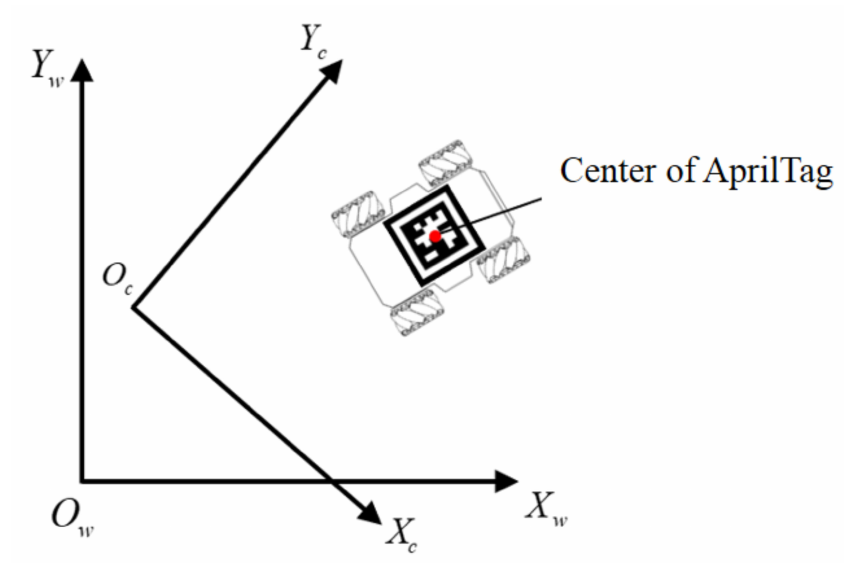
Figure 12. Position and attitude identification of a modular